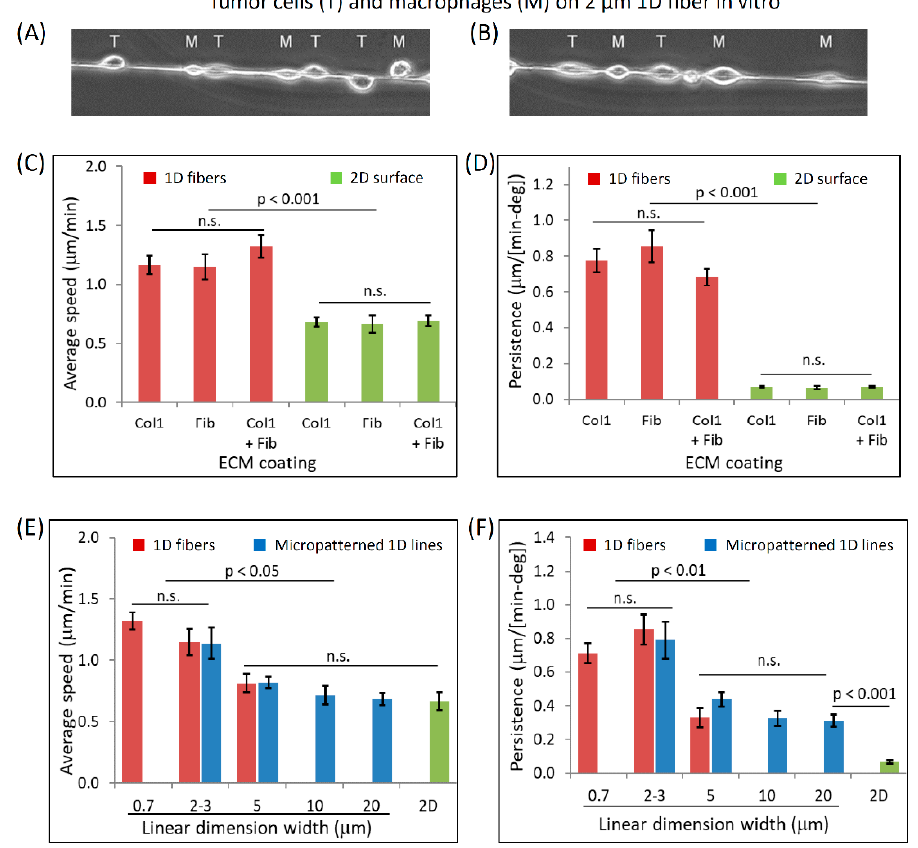
Figure 3. Tumor cells exhibit high-speed migration on thin ECM-coated 1D fibers. ( A , B ) Assembly of streams composed of alternating cell types is a cell autonomous property on 1D fibers. Two examples of tumor cells (MTLn3, labeled T) and macrophages (BAC1.2F5, labeled M) showing alternating streaming pattern on 1D fibers. ( C , D ) Quantification of average cell speed ( C ) and persistence ( D ) of tumor cells migrating on 2 µm fibers vs. on 2D surface coated with different ECM molecules (Collagen I, Fibronectin or Collagen + Fibronectin). Red and green bars represent measurements made on ECM coated (Collagen I, Fibronectin or Collagen I + Fibronectin) 2 µm fibers and on 2D surface, respectively. Data plotted as mean ± SEM; n = 25, 18, 20, 23, 8, and 22 cells for 1D-Col1, 1D-Fib, 1D-Col1 + Fib, 2D − Col1, 2D − Fib, and 2D − Col1 + Fib case, respectively. ( E , F ) Quantifications of average cell speed ( E ) and persistence ( F ) of tumor cells migrating on different thickness 1D fibers (0.7, 2, and 5 µm), micro-patterned 1D lines (2.5, 5, 10, and 20 µm) or 2D surface. Red, blue and green bars represent measurements made on fibronectin coated 1D fibers, 1D micro-patterned lines, and 2D surface, respectively. Data plotted as mean ± SEM; n = 21, 18, and 19 cells for 0.7, 2–3, and 5 µm 1D fibers respectively; n = 20, 17, 16, and 20 cells for micropatterned lines of width 2.5, 5, 10, and 20 µm, respectively; n = 8 cells for the 2D case.